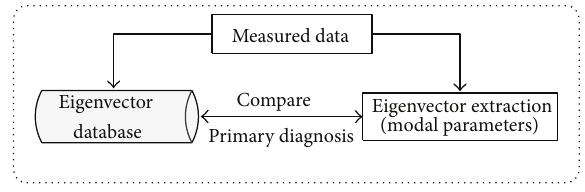
Figure 15: Primary damage diagnosis of